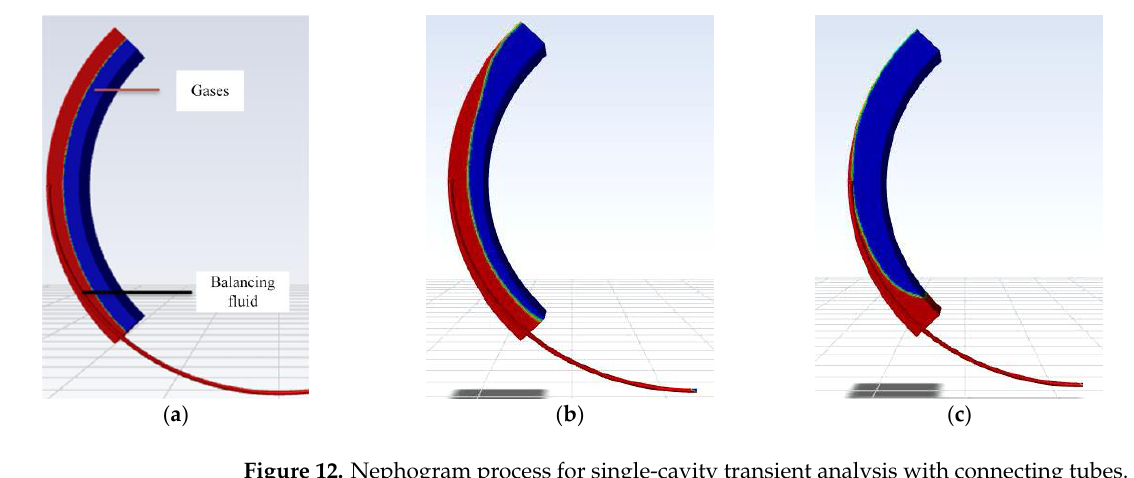
Figure 12. Nephogram process for single-cavity transient analysis with connecting tubes. ( a ) Initial state of gas – liquid homogeneous distribution. ( b ) Gas – liquid two-phase change. ( c ) Gas – liquid two-phase change.